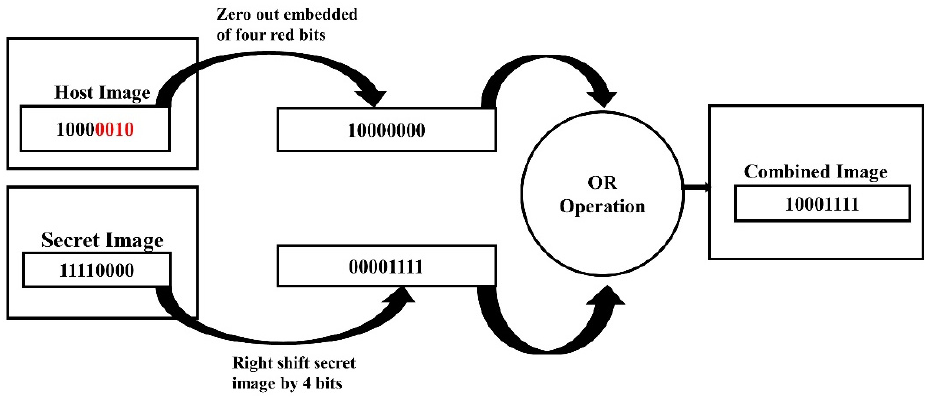
Figure 9. Block diagram of the LSB method (four bit-planes).